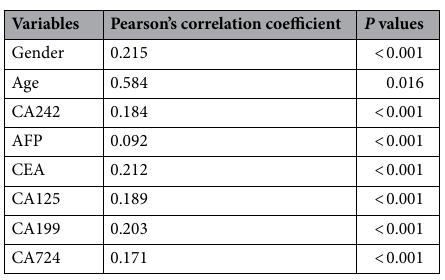
Table 3. Variables significantly correlated with diagnostic results.